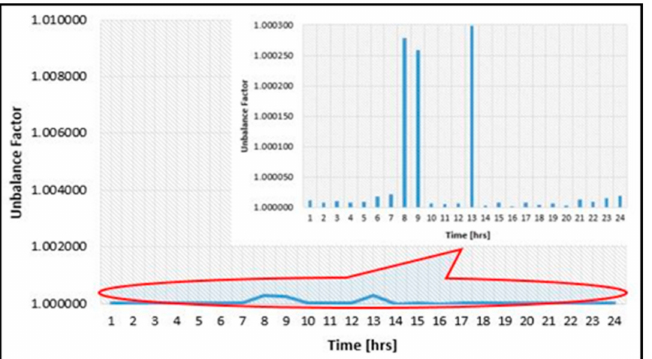
Figure 15. The hourly unbalance factor obtained at the CCP level with the proposed methodology, H-PLB case.